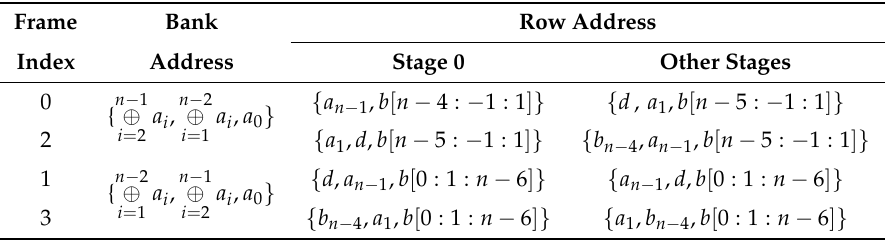
Table 1. Address mapping scheme with 8